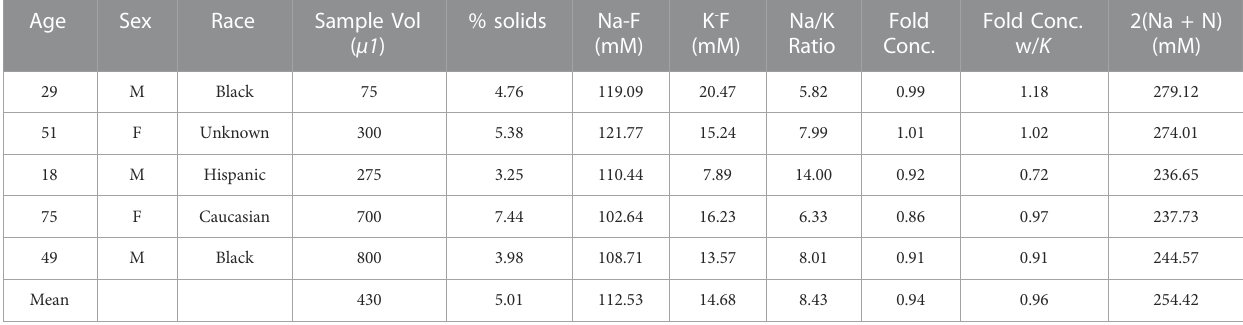
TABLE 1 Isotonic (ISO) Samples — 5 ETT samples collected the week of 01/22/2020-01/29/2020 were foundto have physiological Na + and K + concentrations, fi tting the characterization of “ isotonic ” as previously published. Fold concentration and fold concentration with K specify the proportional difference in tonicity of sample using either Na + concentration alone or with K + . The 2(Na + K) metric is a surrogate measure for total electrolyte